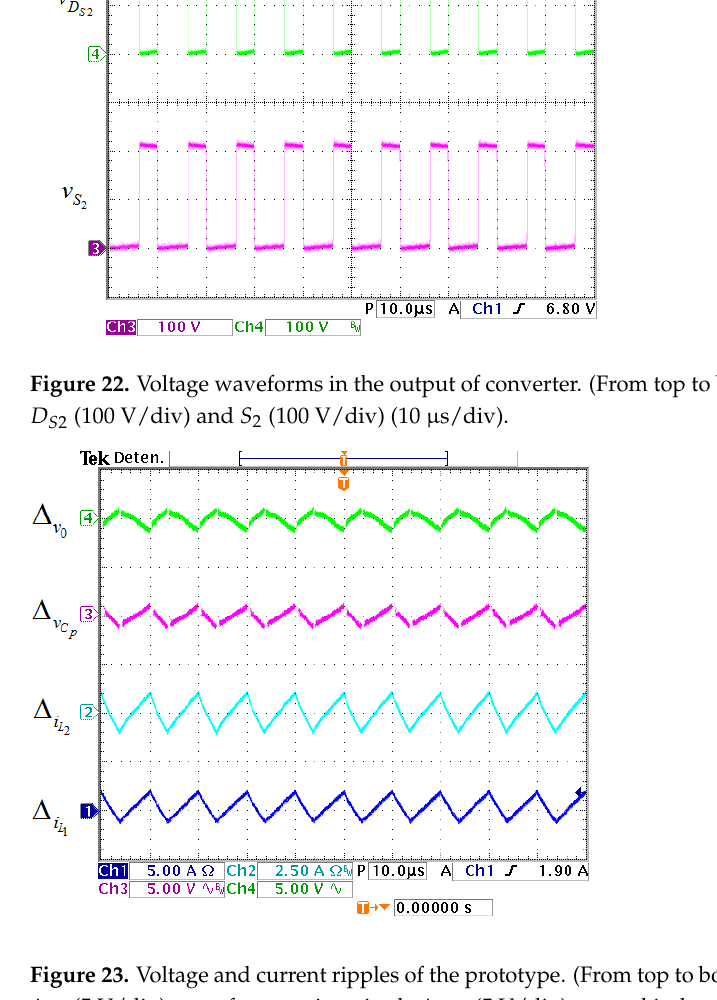
Figure 23. Voltage and current ripples of the prototype. (From top to bottom) Output capacitor ripple first inductor ripple ∆ i L (5 A/div) (10 µ 1